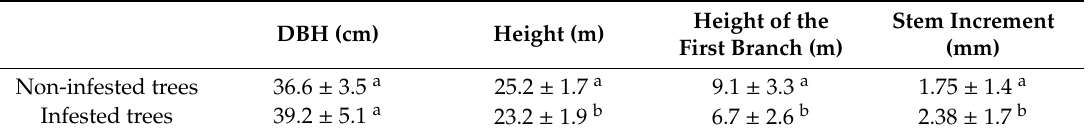
Table 3. Growth traits of non-infested and infested oak trees. Mean ± standard deviations are displayed. Superscript letters (a,b) represent the statistical significance at the level of p = 0.05.